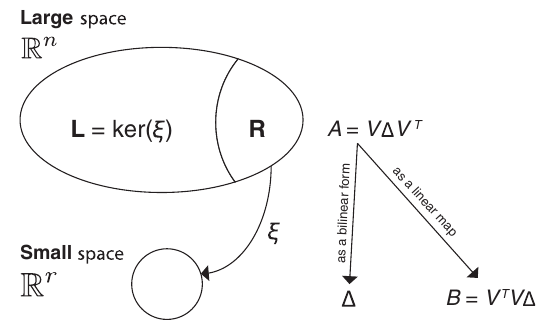
FIG. 1. Representation of the exact rank-reduction scheme. The transformation laws for the matrix representation of the generative model are also